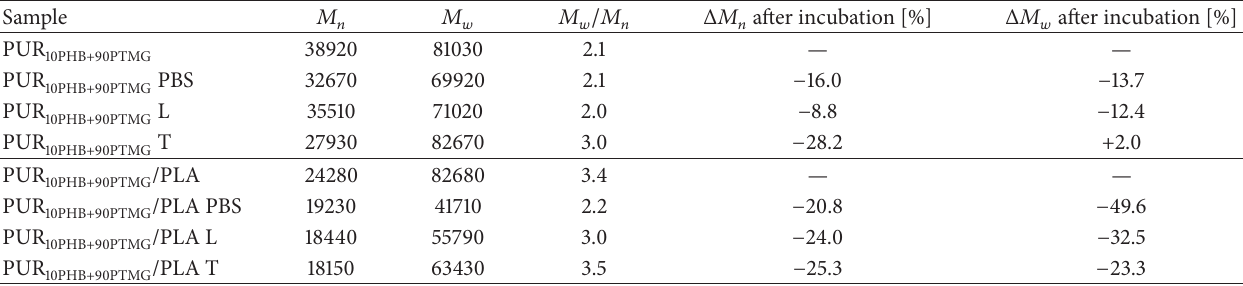
Table 4: Molecular weights of polyurethane (PUR weeks), lipase (L), and trypsin (T) (2 weeks).